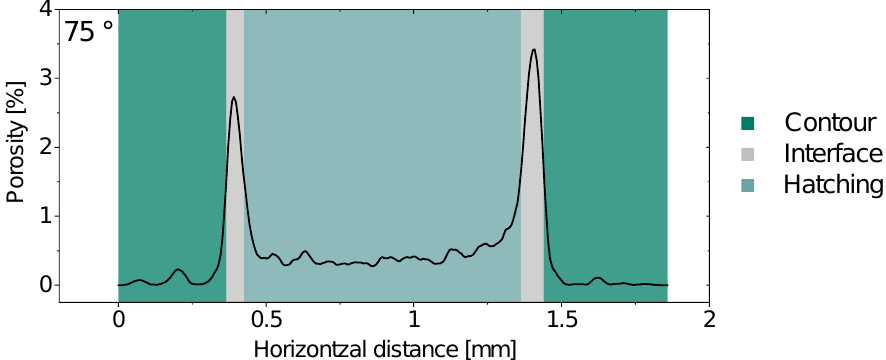
Figure 11. Porosity distribution as a function of the horizontal distance to the downskin surface for a sample built under a construction angle of 75 ◦ .